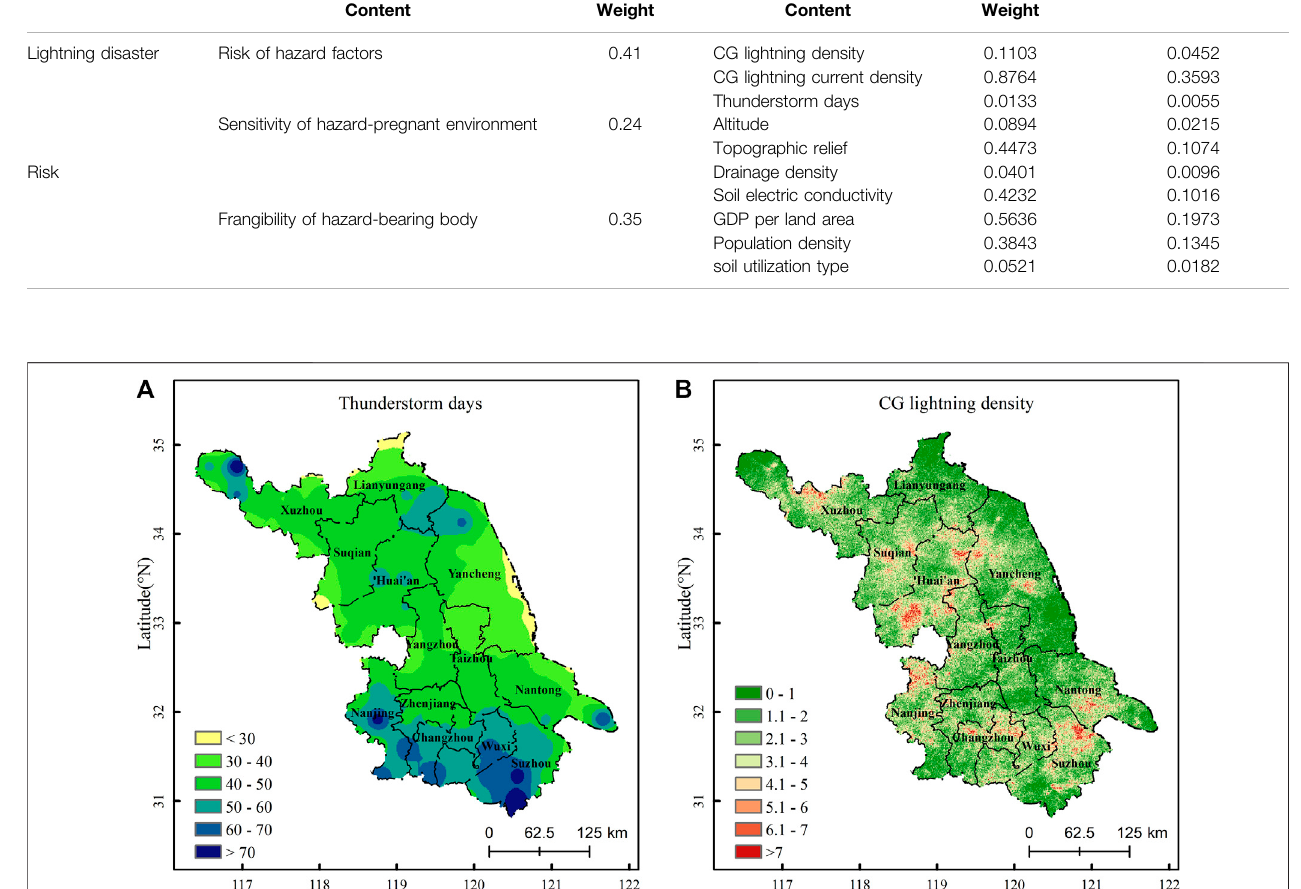
Frontiers in Environmental Science |